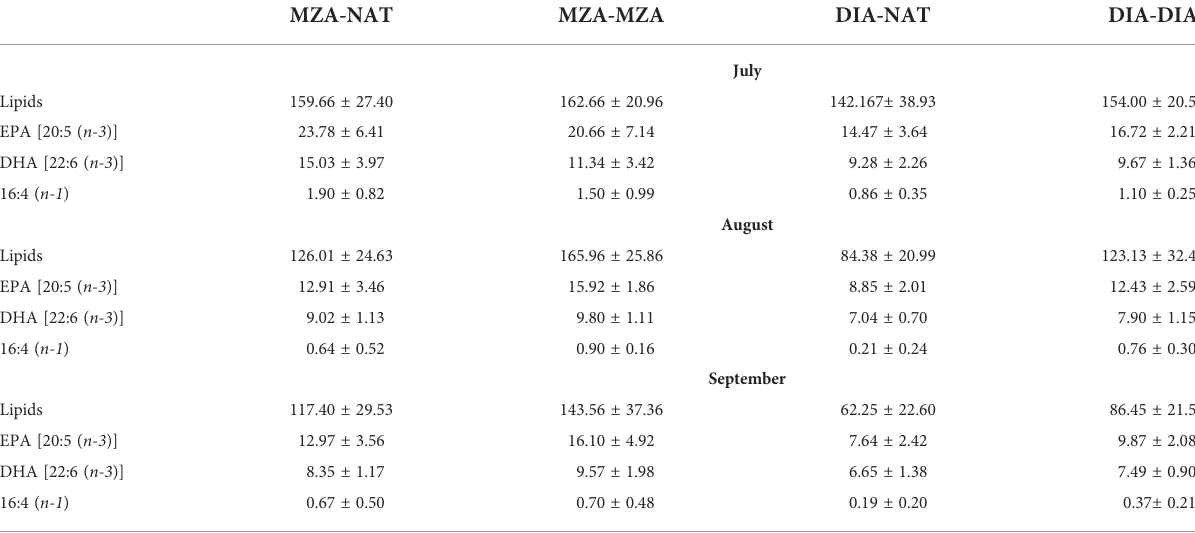
TABLE 6 The mean and standard deviation of total lipids and the fatty acids EPA, DHA and 16:4 ( n-1 ), (µg mg -1 ) in in the various food environment scenario (FES) tanks during July, August and September. MZA-NAT MZA-MZA DIA-NAT DIA-DIA